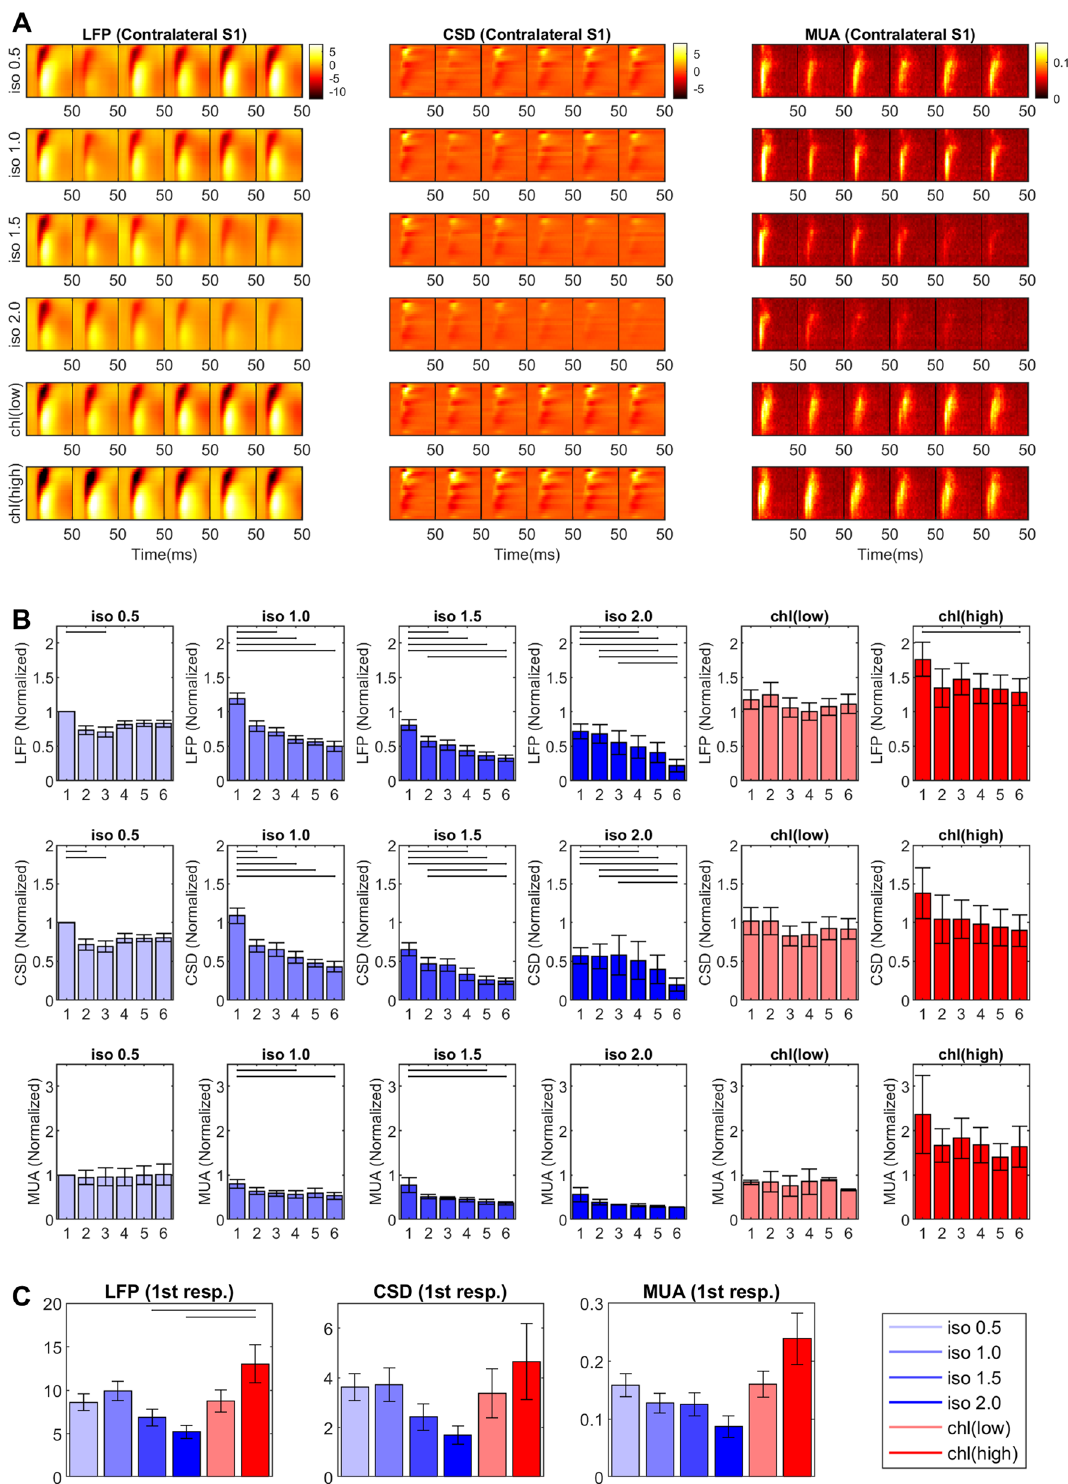
Figure 6. Neural habituation in sensory-evoked responses in a train of forepaw stimulations (1.0 mA, 0.3 μs duration, 3 Hz for 2 s). ( A ) Sequential evoked responses in a stimuli-train (from a representative animal). ( B ) Comparison of the peak amplitude of 6 evoked responses in a train. Response amplitudes in individual animals were normalized to the first (onset) evoked response under isoflurane 0.5% anesthesia. ( C ) Peak amplitude of the first evoked response in a train compared across anesthetic conditions. Horizontal bar: p < 0.05 in post-hoc Tukey’s test. (n = 16; 8 rats × 2